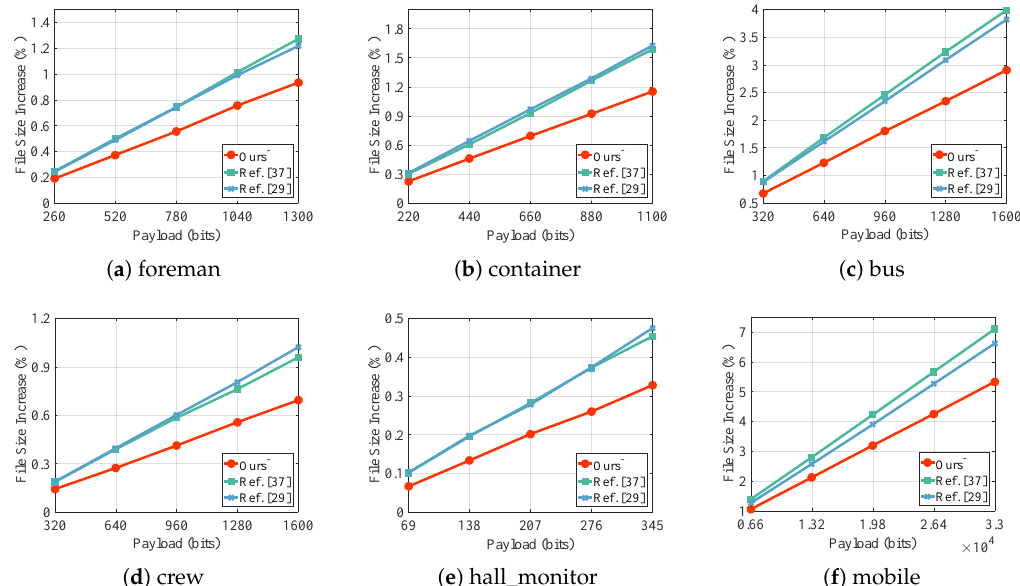
Figure 10. The increase in the file size of marked video generated by different schemes without using the ( 0,0 ) coefficient pairs when QP is